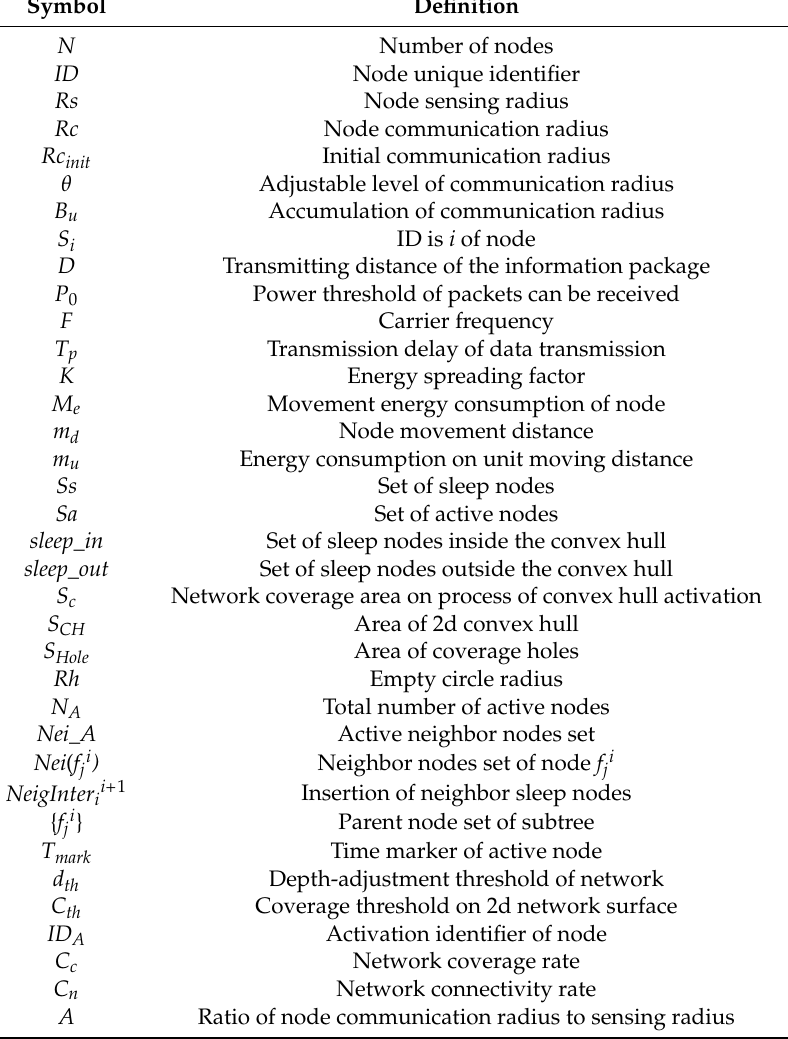
Table 3. Main Symbolic Notation of the NDACS